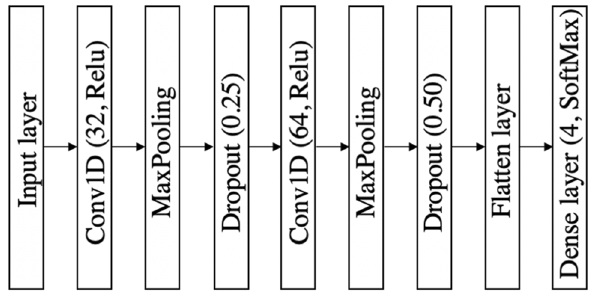
Fig. 4 The Lightweight CNN architecture used in LimitAc-